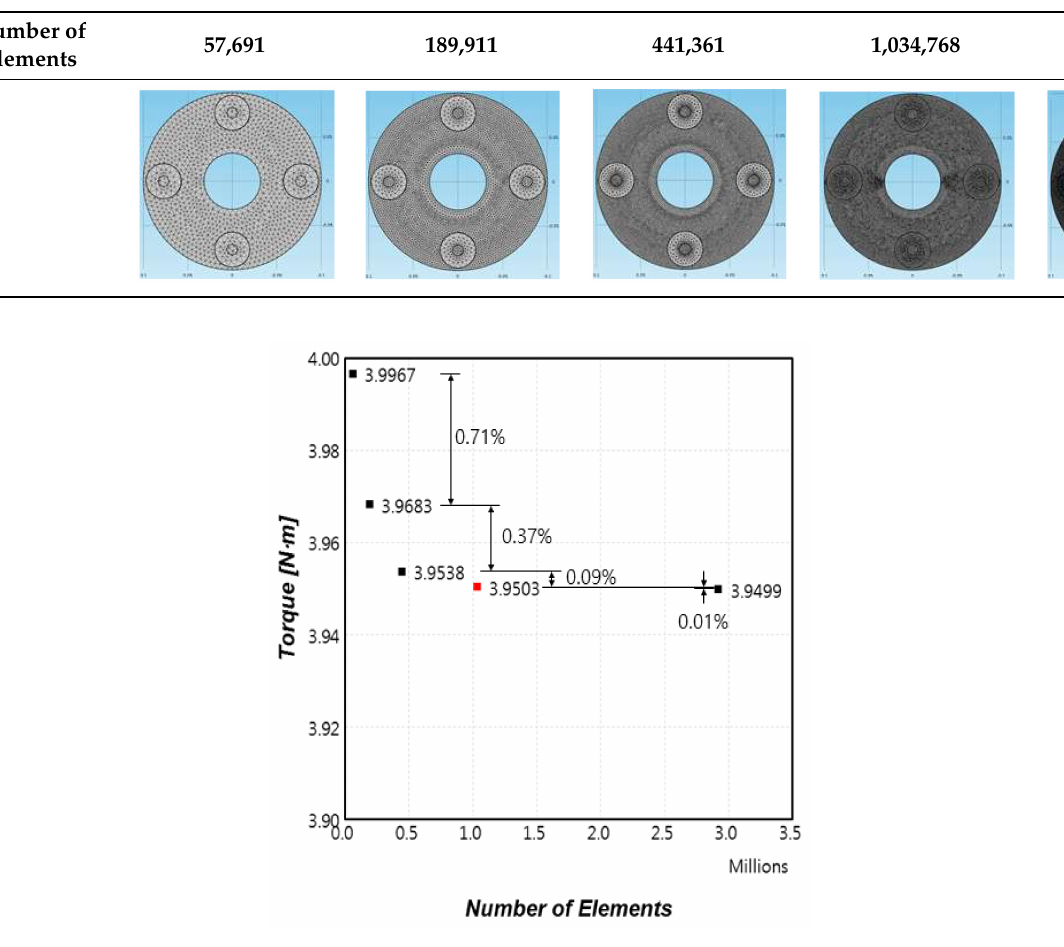
Figure 4. Torque vs. number of elements